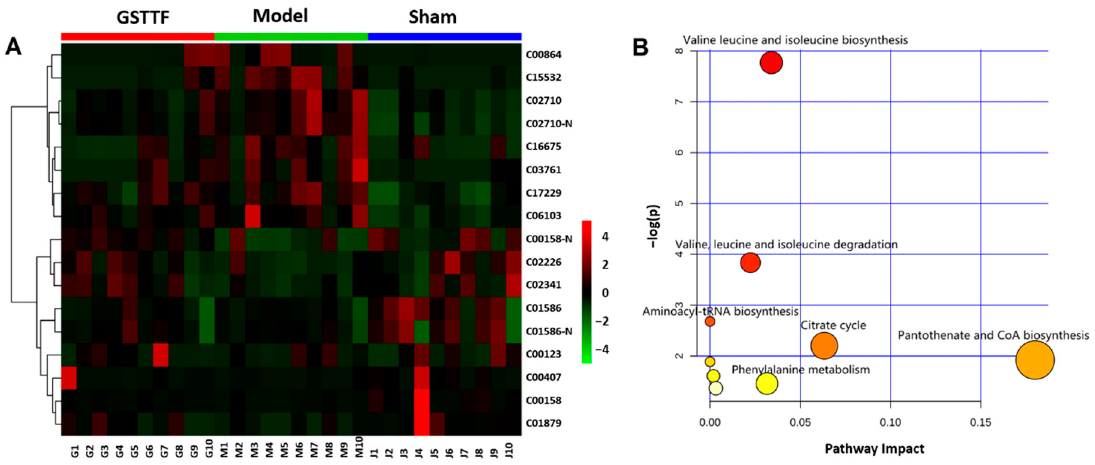
Figure 4. Heat map ( A ) visualizing the changes in the intensities of potential biomarkers and bubble plot ( B ) of the main perturbed pathway response to MCAO.